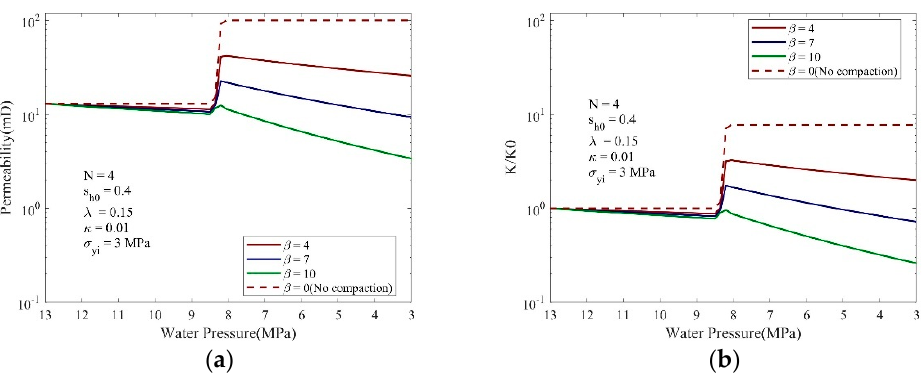
Figure 7. The effect of parameter β on ( a ) permeability and ( b ) permeability ratio.